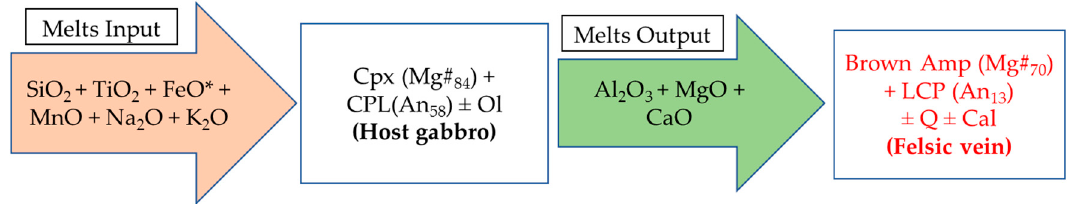
Figure 21. Schematic diagram describing felsic vein formed by replacement process. CPL: Calcic plagioclase. Cpx: Clinopyroxene. LCP: Less calcic plagioclase. Q: Quartz. Cal: Calcite.